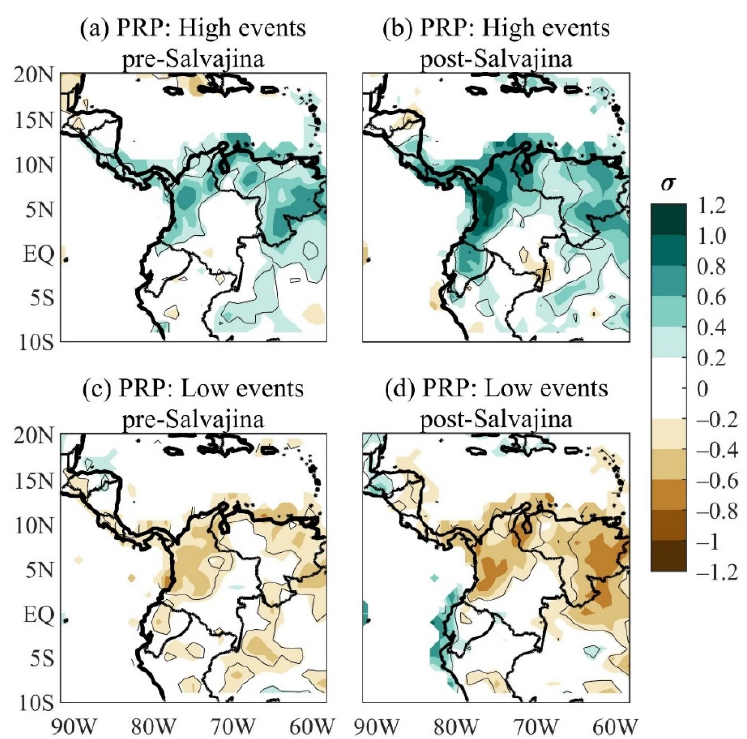
Figure A1. Standardized precipitation anomalies during: ( a ) high discharge events pre-Salvajina; ( b ) high discharge events post-Salvajina; ( c ) low discharge events pre-Salvajina; and ( d ) low discharge events post-Salvajina. Shading interval: 0.2 SD. Continuous contours indicate significant values at 95% confidence level. Based on Global Precipitation Climatology Center (GPCC) results.